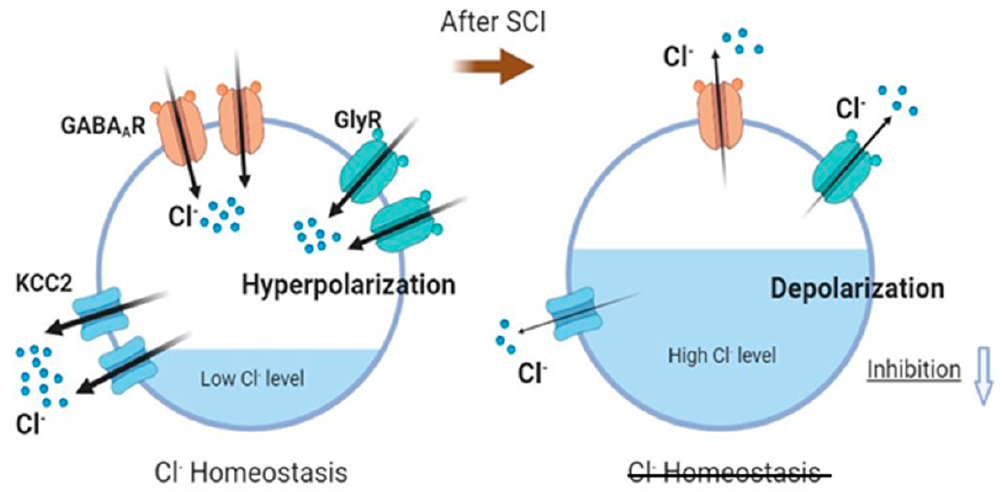
Figure 9. Downregulation of inhibitory receptors and chloride ions extruder KCC2 in MNs occurs early postinjury period causing a decrease of postsynaptic inhibition. In basal conditions, KCC2 maintains a low-level of intracellular chloride ions, and the activated GABA A Rs and GlyRs allow an influx of chloride ions, generating a hyperpolarization. After SCT, a decrease of the KCC2 may lead to the accumulation of high concentrations of Cl − inside MNs, and evoke a depolarizing instead of an inhibitory response, suggesting the possibility of a decrease in inhibition. Illustration created with BioRender.com, 1 June 2022.